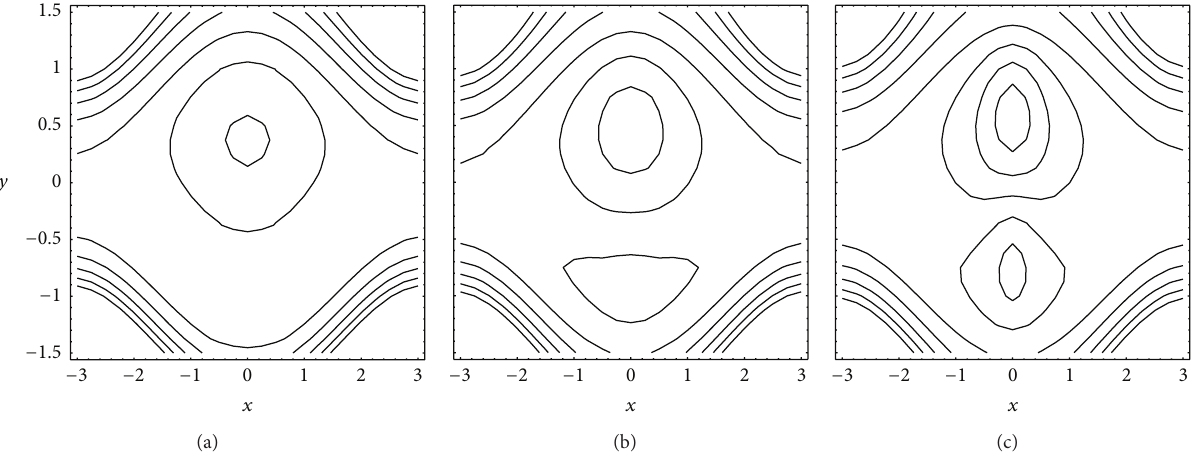
Figure 7: Streamlines for different 𝑁 (a) 0.1, (b) 0.9, and (c) 1.0 with fixed 𝑎 = 0.5 , 𝑏 = 0.5 , 𝑑 = 1 , 𝜙 = 0 , Gr = 5 , 𝜃 = 1.1 , 𝑛 = 2 , and 𝑏 𝑠 = 0.01